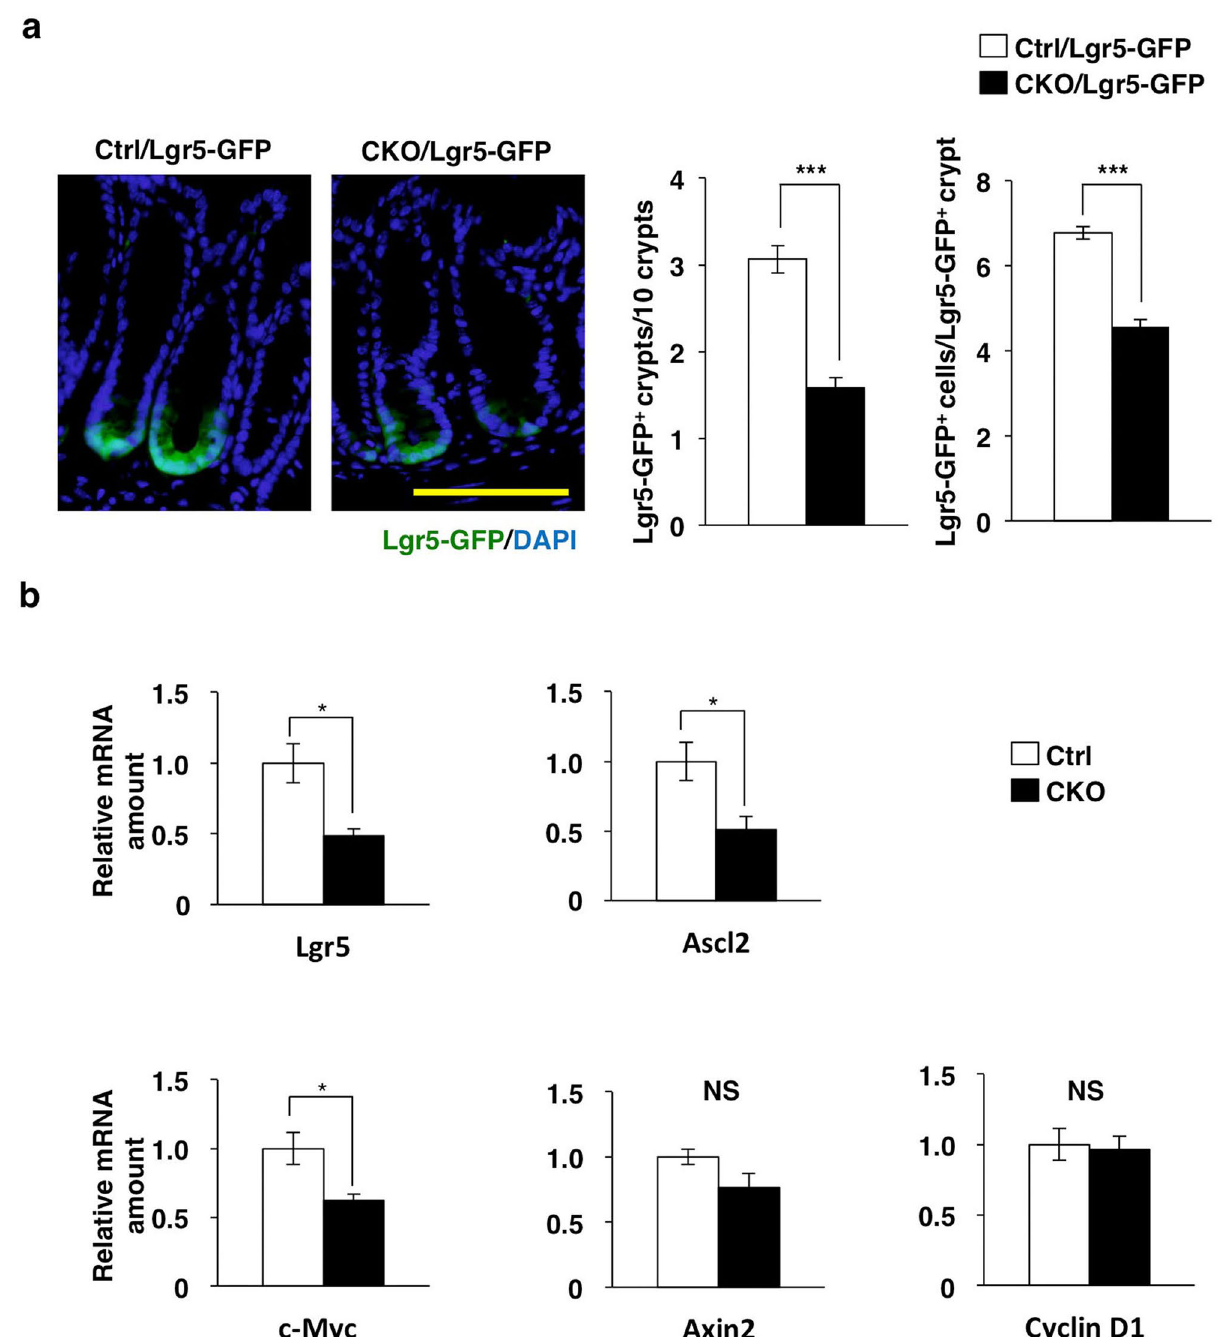
Figure 2. Marked reduction in the number of Lgr5-positive stem cells in the colon of Tsc2 CKO mice. ( a ) Frozen sections of the colon from control/Lgr5-GFP and Tsc2 CKO/Lgr5-GFP mice at 8- to 10-week-old were stained with 4 ′ ,6-diamidino-2-phenylindole (DAPI, blue) to detect nuclei and examined for GFP fluorescence (green). Representative images (scale bar, 100 μm) as well as quantitative analysis both of the number of Lgr5- GFP–positive crypts per 10 crypts (means ± s.e. for 994 crypts from three control/Lgr5-GFP mice and 1,002 crypts from three Tsc2 CKO/Lgr5-GFP mice) and of the number of Lgr5-GFP–positive cells per Lgr5-GFP– positive crypt (means ± s.e. for 90 Lgr5-GFP–positive crypts from three control/Lgr5-GFP and three Tsc2 CKO/ Lgr5-GFP mice) are shown. *** P < 0.001 (Student’s t test). ( b ) Quantitative RT-PCR analysis of Lgr5, Ascl2, c-Myc, Axin2, and cyclin D1 mRNAs in CECs isolated from control and Tsc2 CKO mice at 9- to 12-week- old. The amount of each mRNA was normalized by that of Hprt1 mRNA and then expressed relative to the normalized value for control mice. Data are means ± s.e. from three separate experiments. * P < 0.05; NS, not significant (Student’s t